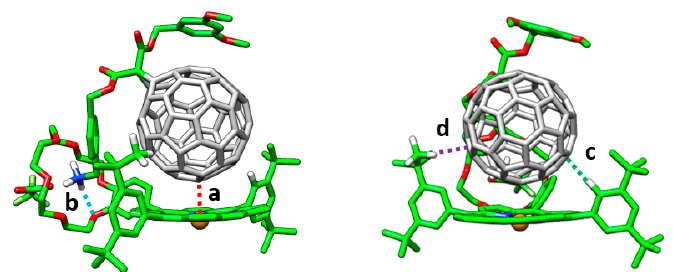
Figure 10. Minimum-energy geometries calculated for the 8-Cu•7 complex at the PM7 level. Side ( Left ) and front ( Right ) views are displayed. The different types of intermolecular contacts are denoted with labels a–d. Only relevant hydrogen atoms are displayed for clarity. Except for C 60 carbon atoms depicted in grey, the following color code is used: carbon in green, nitrogen in blue, oxygen in red and hydrogen in white. Table 3. DFT-optimized (B97-D/6-31G*) intermolecular distances (a–d, in Å) characterizing the 8-M • 7 associates, and binding energies ( E bind , in kcal/mol) computed at the PBE0-D3/cc-pVTZ level [92] 1 .